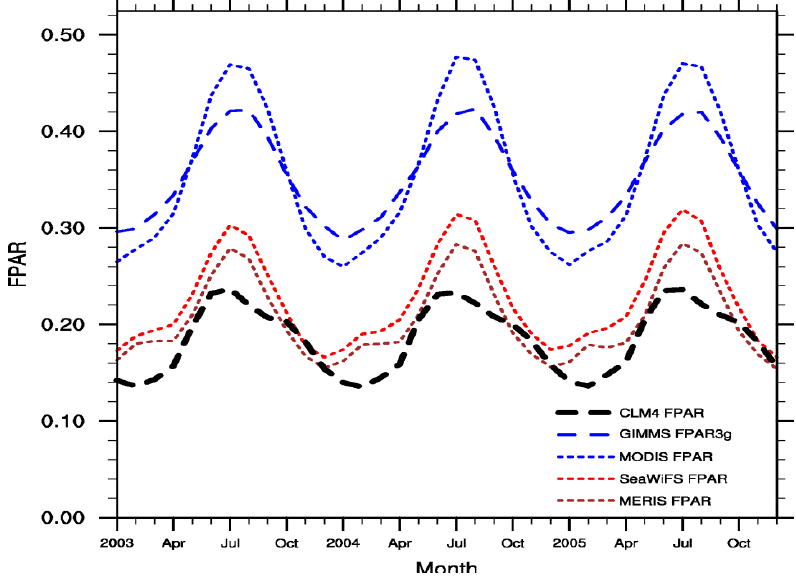
Figure 13. Monthly mean FPAR for the global from 2003 to